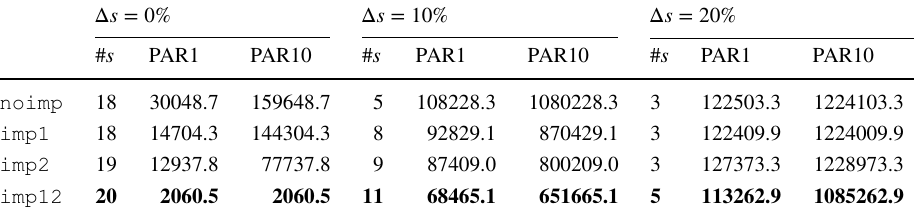
Fig. 5 Branching variables decided by the solver along its execution, for a random during their first 130, 000 decisions (solved by imp12 in 126, 770 decisions)